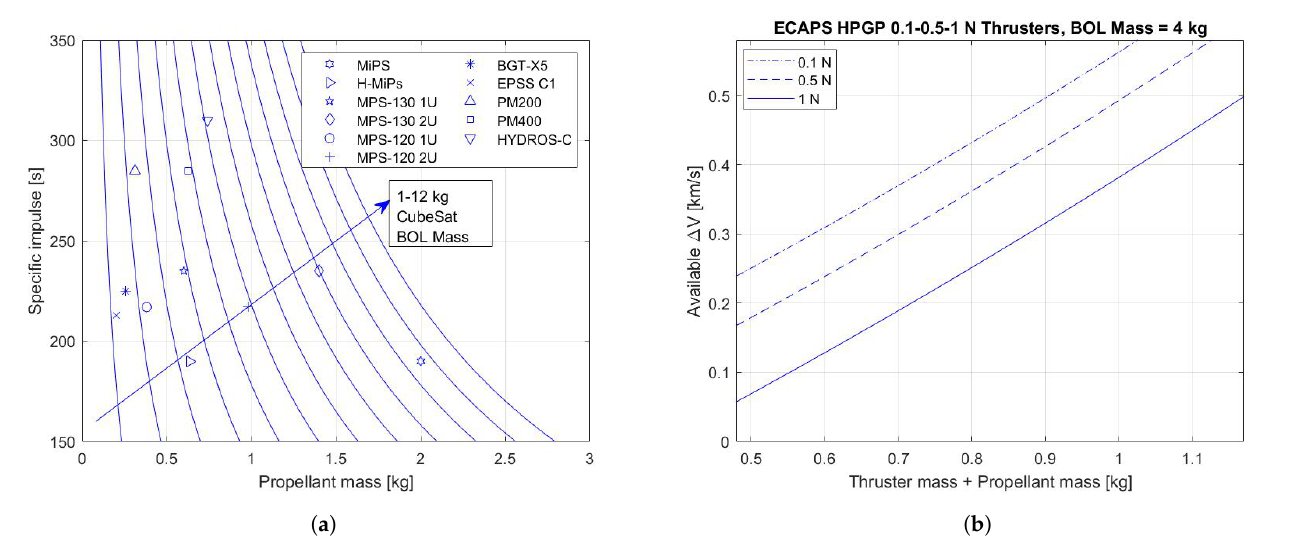
Figure 4. ( a ) Micro-propulsion systems evaluation chart (blue lines from left to right represent CubeSat Beginning-Of-Life (BOL) mass 1–12 kg); ( b ) Performances of the ECAPS HPGP